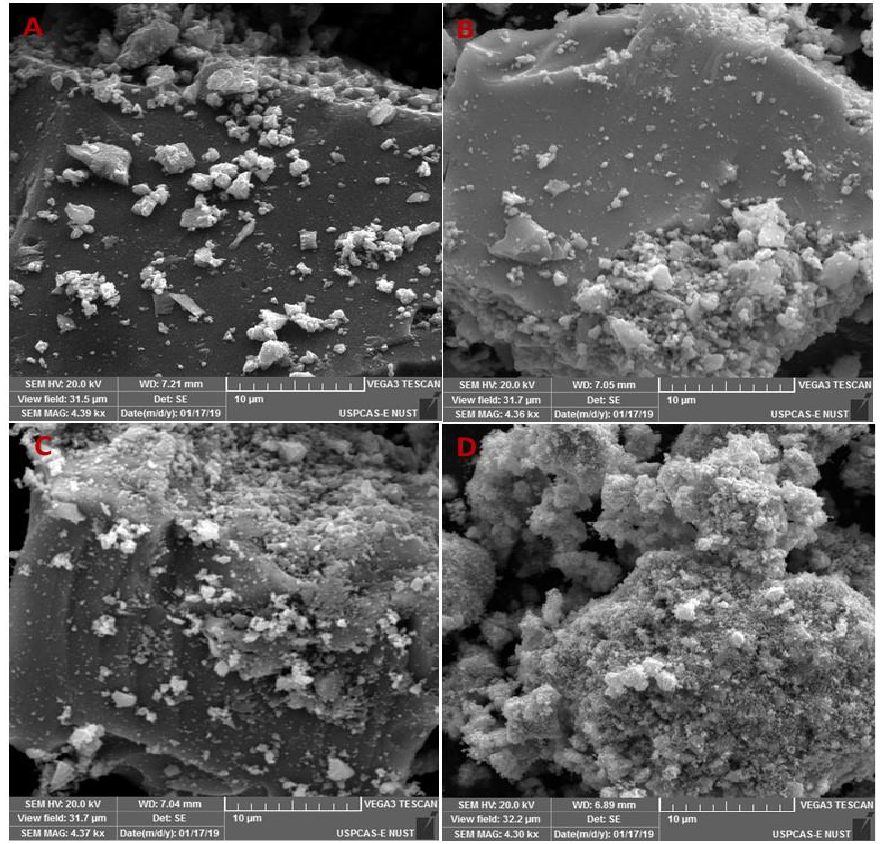
Figure 3. Scanning electron micrographs of SnO 2 NPs calcined at 100 °C ( A ), 300 °C ( B ), 600 °C ( C ), and 900 °C ( D ).